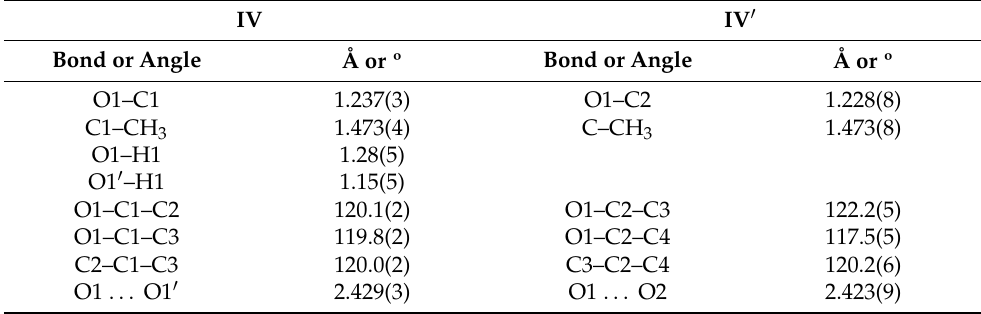
Figure 9. The proton disolvate in two polymorphs of salt (Ac-H + -Ac)(Cl 11 − ). In polymorph IV b , it was not possible to localize the bridging proton by X-ray diffraction analysis. Table 6. Selected geometric parameters of proton disolvates IVa and IVb (averaged over two independent fragments (acetone molecules) of the adduct) according to X-ray data .